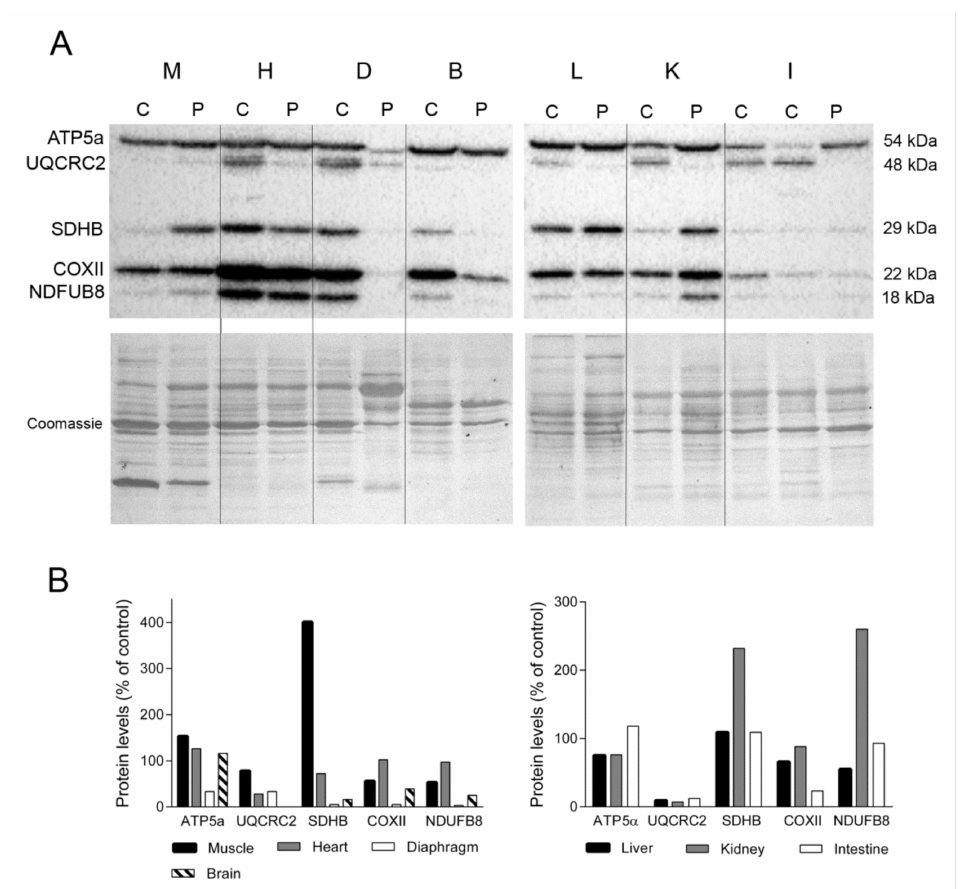
Figure 2. OXPHOS system subunits. ( A ) Representative Western blotting of OXPHOS system subunits in tissue homogenates of a control (C) (n = 3 for muscle, n = 1 for other tissues) and the patient (P). Shown below is a representative Coomassie blue-stained gel. ( B ) Densitometry analysis: protein levels were normalized to total protein loading according to Coomassie blue staining. Data are expressed as percentage of control values. Abbreviations: M, skeletal muscle; H, heart; D, diaphragm; B, brain; L, liver; K, kidney; I, intestine. Two samples of control intestine are shown; large (left) and small (right). ATP5a, ATP synthase subunit alpha; UQCRC2, ubiquinol-cytochrome C reductase core protein 2; SDHB, succinate dehydrogenase complex iron sulfur subunit B; COXII, cytochrome